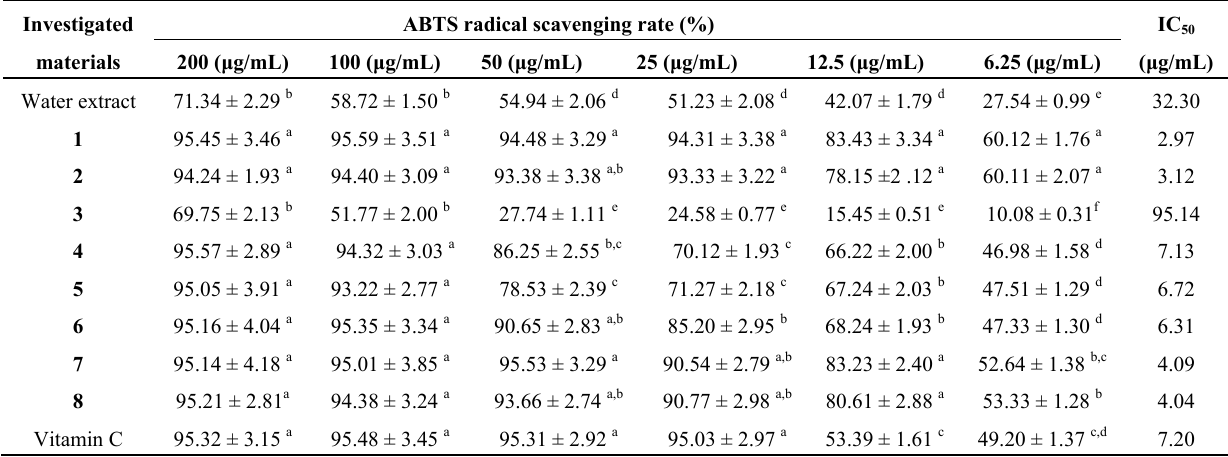
Table 2. ABTS radical scavenging